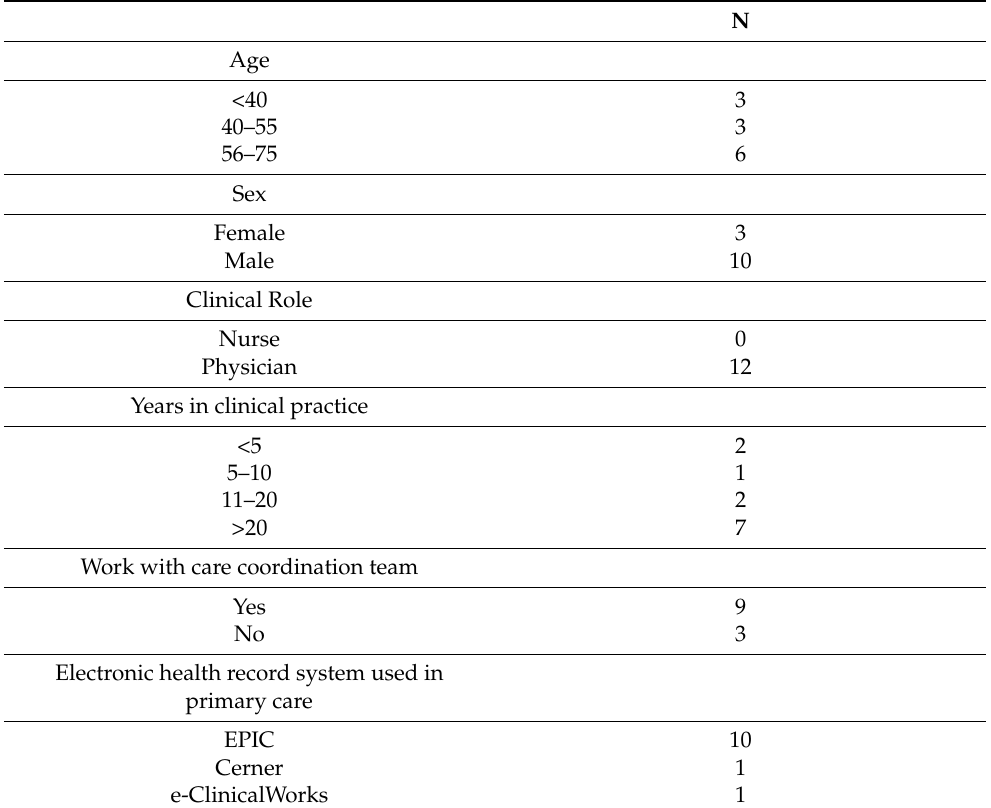
Table 3. Demographics of Respondents who completed the Survey (N = 12).